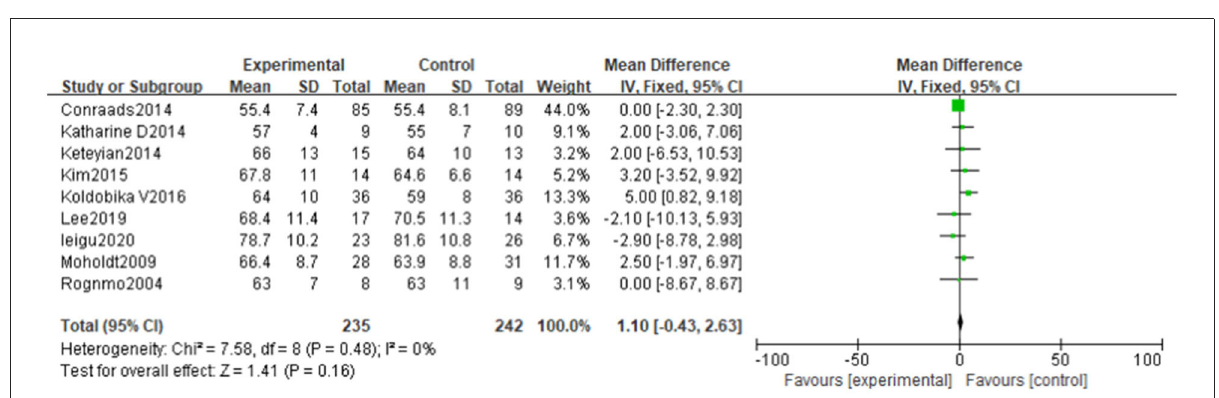
FIGURE8 Forest plot of the effects of high-intensity and moderate-intensity exercise on RHR in CAD patients.